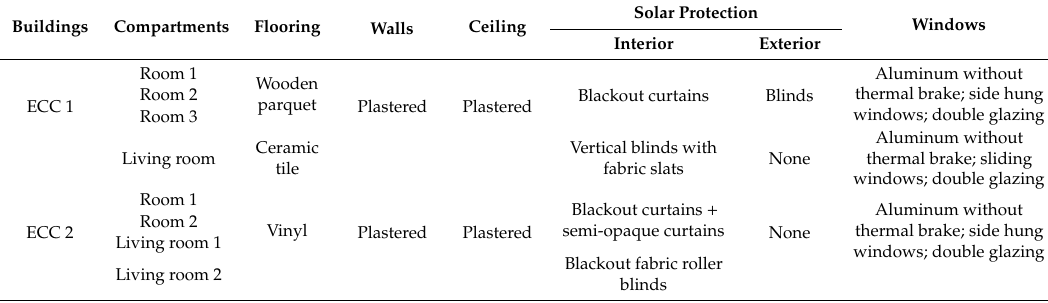
Table 2. Viseu: interior cladding, windows, and solar protection of the various compartments.